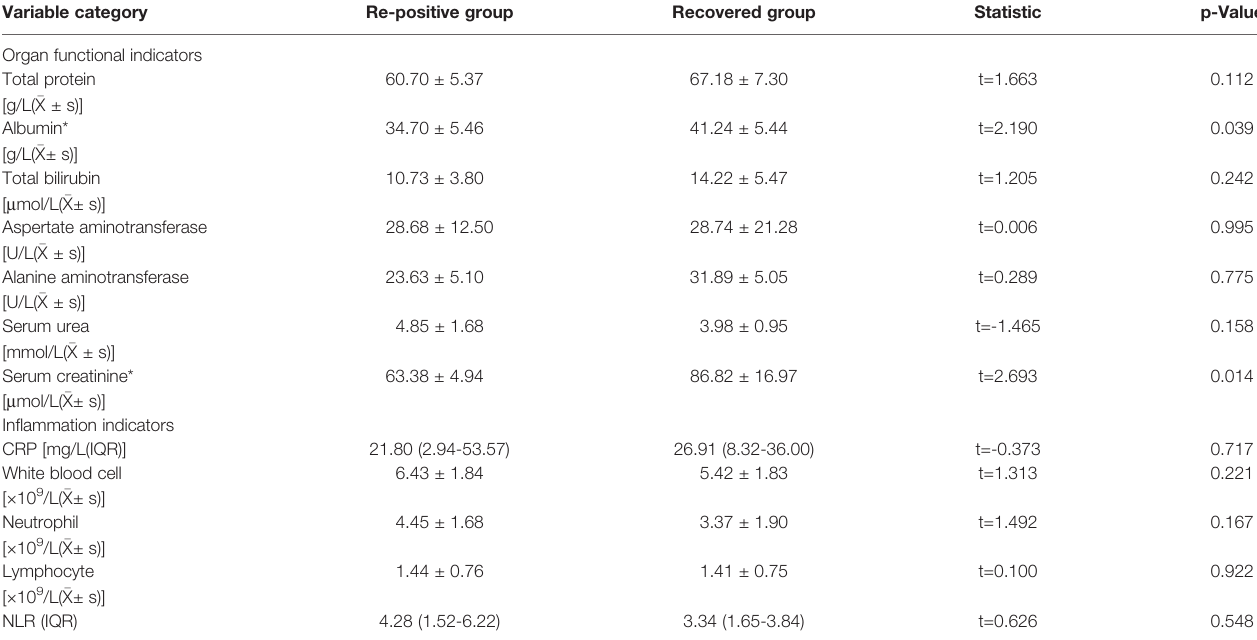
TABLE 2 | Comparison of laboratory indicators between re-positive and recovered group.